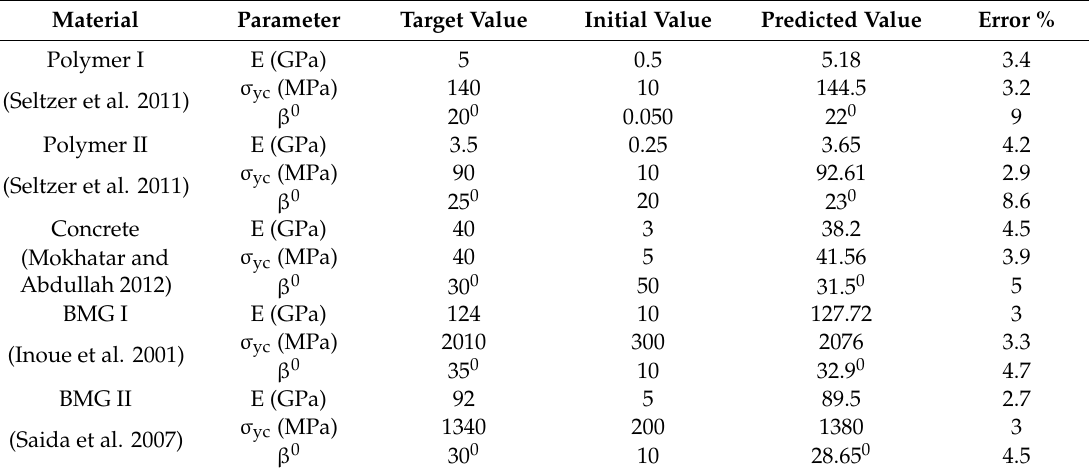
Table 5. Sensitivity and accuracy analysis of S&B optimization method. Figure 13. Sensitivity and accuracy results of S&B optimization algorithms.